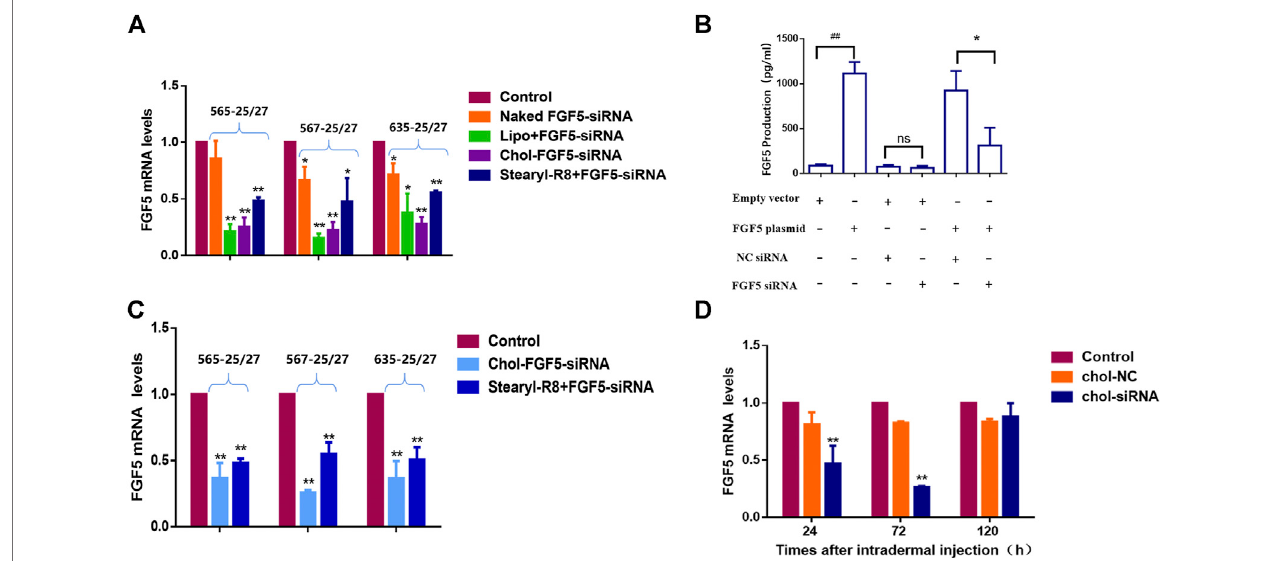
FIGURE 1 | Effects of different FGF5-targeting siRNA delivery methods on the expression of FGF5 (A) Changes in FGF5 mRNA level in NIH-3T3 cells overexpressingtheFGF5genethatweretransfectedwithdifferentpreparationsofFGF5-targetingsiRNAasdeterminedbyqPCR.NIH-3T3cellswereincubatedwithout (control) or with naked FGF5 siRNA, lipo + FGF5 siRNA, chol-FGF5-siRNA or Stearyl-R8+FGF5-siRNA for 24 h and the levels of FGF5 mRNA in these cells were measured by qPCR. Dataare mean ± SD from three experiments. * p < 0.05, ** p < 0.01 vs. control (B) Effect of FGF5 siRNA on the expression ofFGF5 in NIH-3T3 cells. NIH-3T3 cells were transfected with an empty vector or vector containing the FGF5 gene and the level of FGF5 secreted by the cells was then measured by ELISA following transfection with the cholesterol-modi fi ed negative control siRNA (NC siRNA) or cholesterol-modi fi ed FGF5 siRNA. Data are mean ± SD from three experiments. ## p < 0.05, ** p < 0.01 (C) Effect of FGF5 siRNA on FGF5 mRNA level in mouse skin. The skin of the animal was either not treated with siRNA (control) or treated with Chol-FGF5-siRNA or the Stearyl-R8 bound FGF5-siRNA by intradermal injections, and the level of FGF5 mRNA in the skin was measured by qPCR after 24 h.Dataaremean ± SD( n (cid:2) 3).** p < 0.01vs.control (D) ChangesinFGF5mRNAlevelinmouseskinovertimefollowingtheadministrationofFGF5siRNA.Chol-FGF5- siRNA or Chol-NC-siRNA was administered to the skin of mice by intradermal injection, and the mRNA level of FGF5 in the skin was measured after 24, 72, 120 h, respectively, using qPCR. Data are mean ± SD ( n (cid:2) 3). ** p < 0.01 vs.